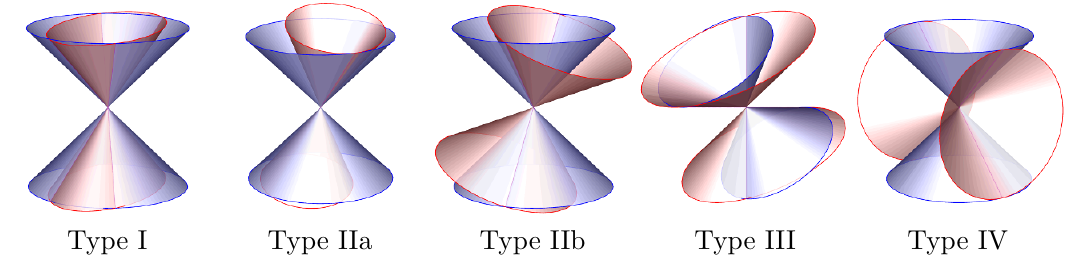
Figure 4 . Null cones corresponding to di(cid:11)erent allowed g and f